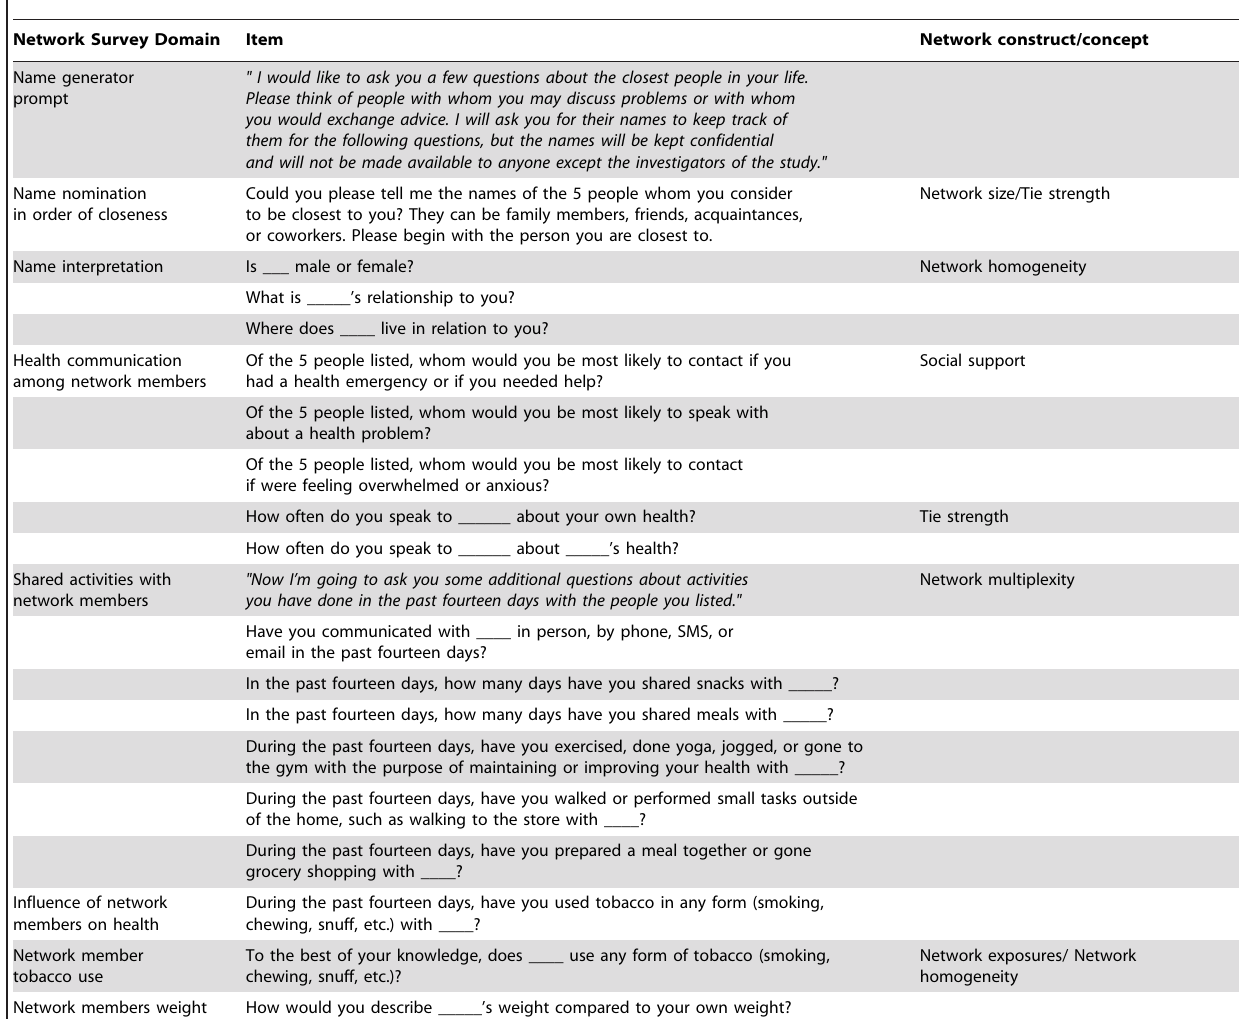
Table 2. Survey domains and underlying network